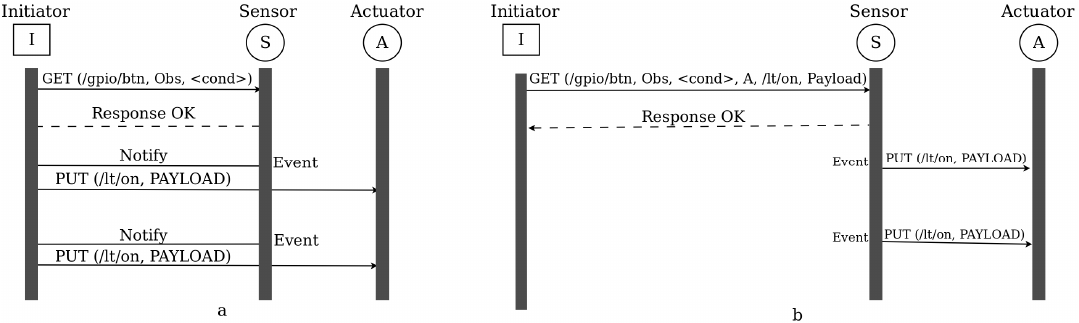
Figure 4. Sensor-Actuator Interaction. ( a ) Indirect; ( b ) Direct Binding.